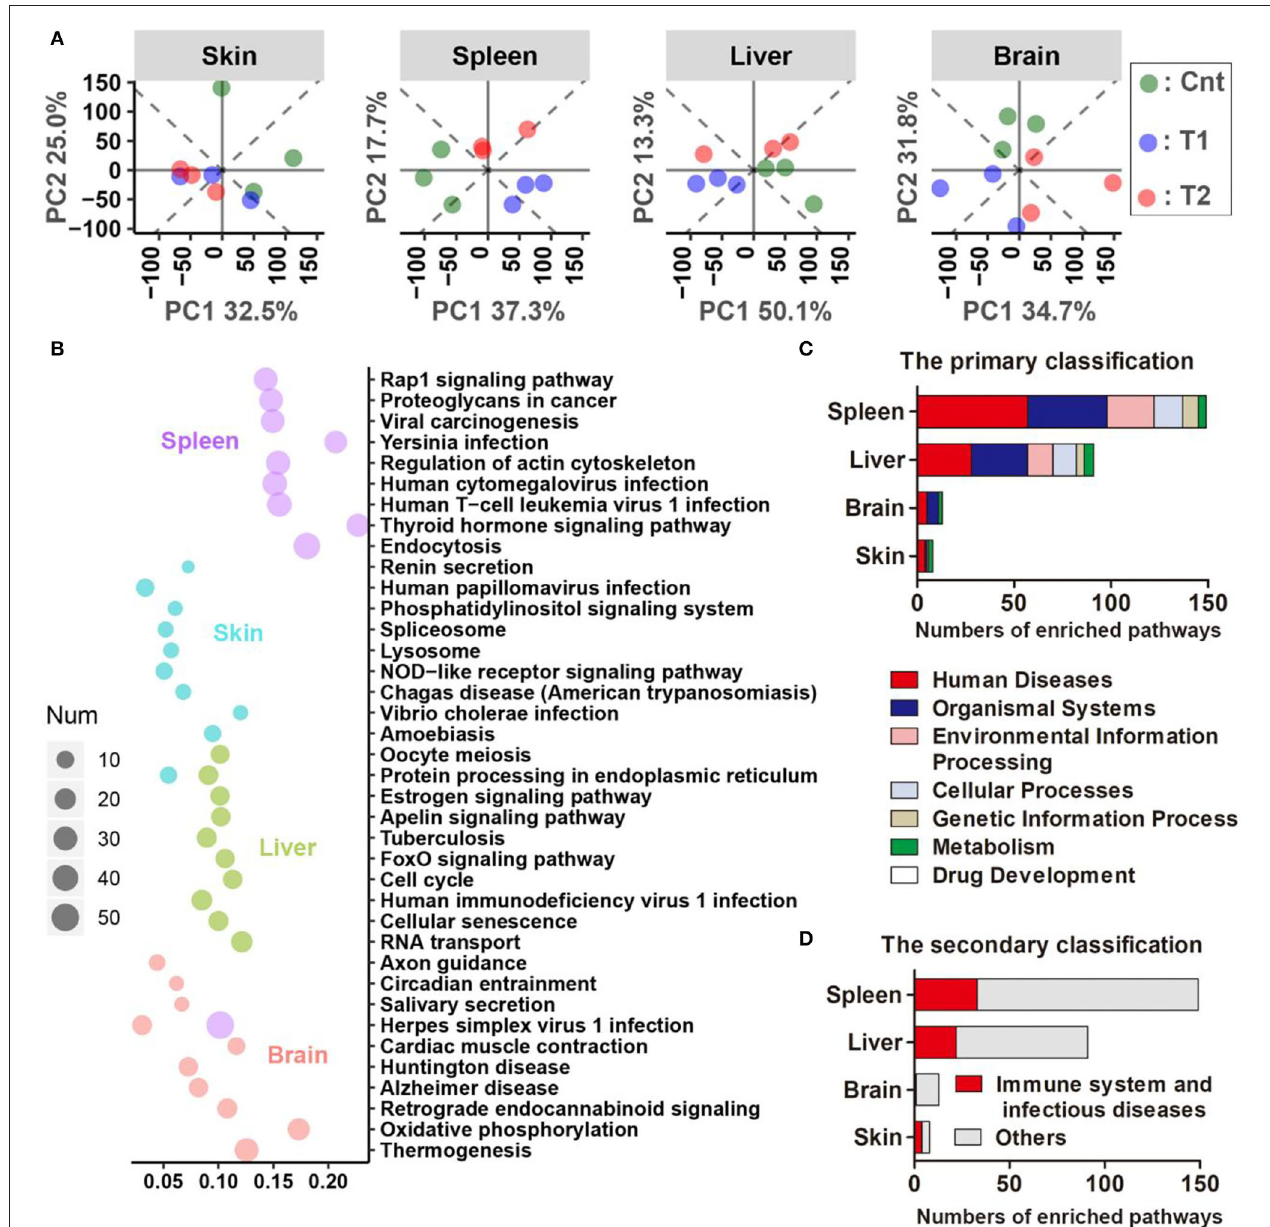
FIGURE 6 | Results of comparative transcriptomic analyses. (A) Principal component analysis (PCA) scatter plots present the dissimilarity of the transcriptional profile between groups. (B) The top 10 Kyoto Encyclopedia of Genes and Genomes (KEGG) pathways (ordered by q -value) of each organ are enriched by the differently expressed genes (DEGs) ( p < 0.01, one-way ANOVA). The size of each dot denotes the number of DEGs enriched in each pathway. The horizontal axis stands for the enrichment cover rate of each pathway (enriched gene number/total gene number of this pathway). It should be noted that many immune pathways in the KEGG database are named after the pathogens, but they may share considerable immune proteins in their signal transduction networks. For example, the highlight of the Herpes simplex virus 1 pathway might not mean the infection of this virus in the giant salamander, but it emphasizes that there were a lot of immune-related genes that varied after pre-exposure. (C,D) Statistics on the functional category of all the significantly enriched pathways (corrected p < 0.05). KEGG pathways are classified into seven categories at the primary classification level. Each primary category is further divided into secondary classes according to its cellular function (https://www.